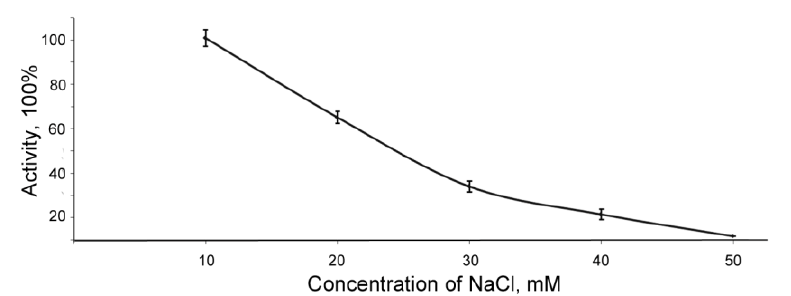
Figure 3. Effect of NaCl on the bacteriolytic activity of BlpLc. Values represent means ± standard deviations of three independent measurements.